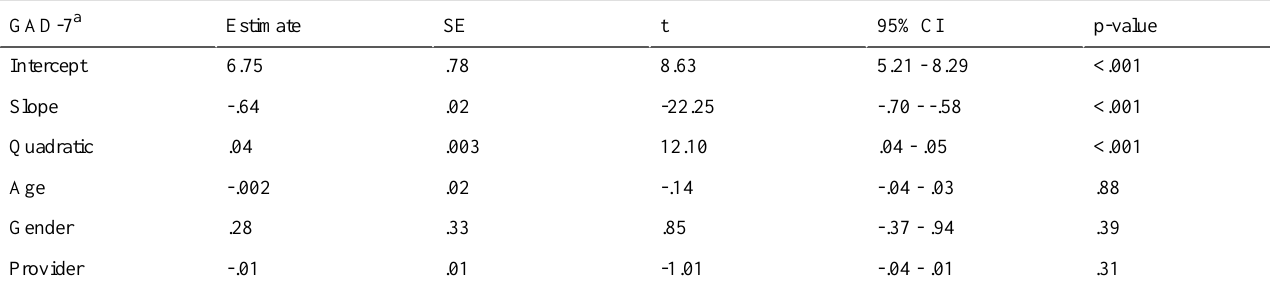
Table 4. Age, gender, and provider as predictors of the intercept, slope, and quadratic components for anxiety